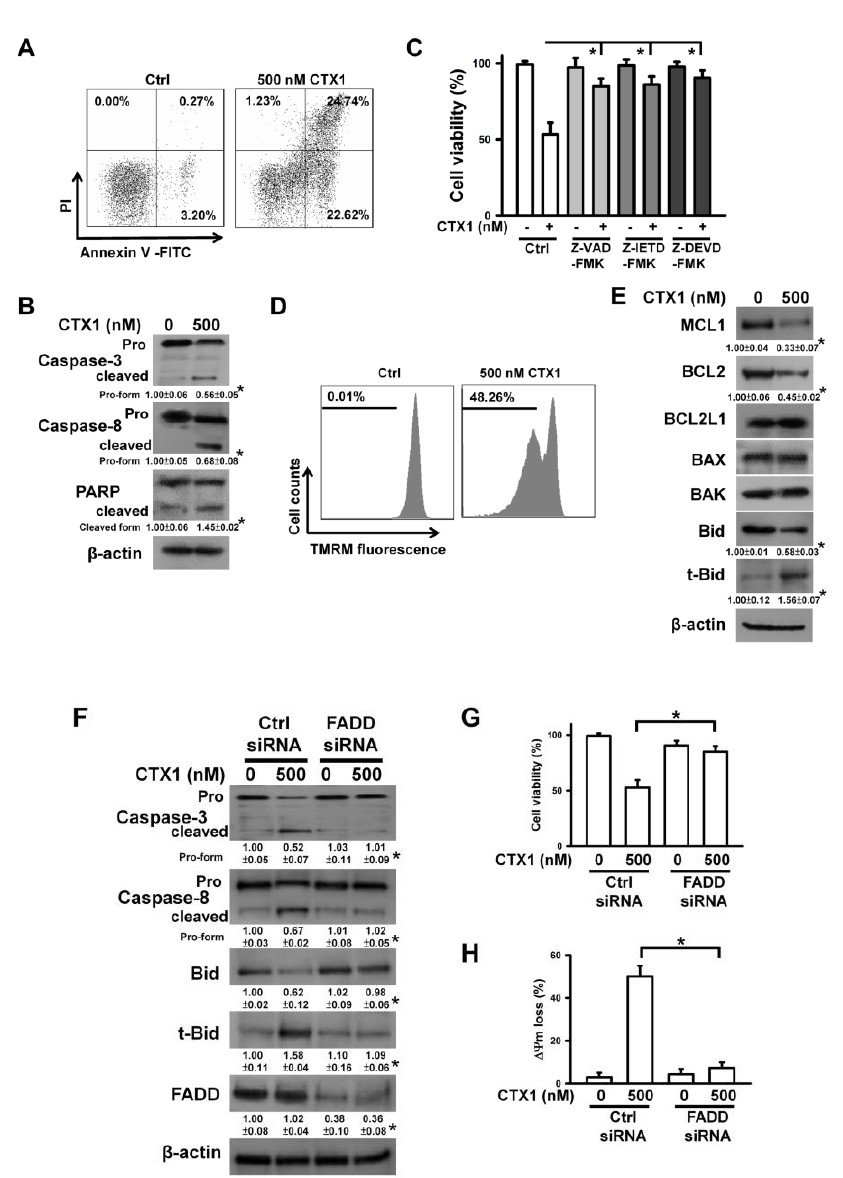
GLX351322 eliminated ROS generation and cell death induced by CTX1 (Figure 6D,E), suggesting the involvement of Ca 2+ and ROS in CTX1-induced HL-60 cell death. CTX1 induced p38 MAPK activation (Figure 6F), while BAPTA-AM or GLX351322 blunted this CTX1-induced effect (Figure 6G,H). Moreover, BAPTA-AM abolished the CTX1-induced increase in NOX4 protein and mRNA expression (Figure 6I,J). These results indicate that CTX1 induces Ca 2+ /NOX4/ROS axis-mediated p38 MAPK activation in HL-60 cells.